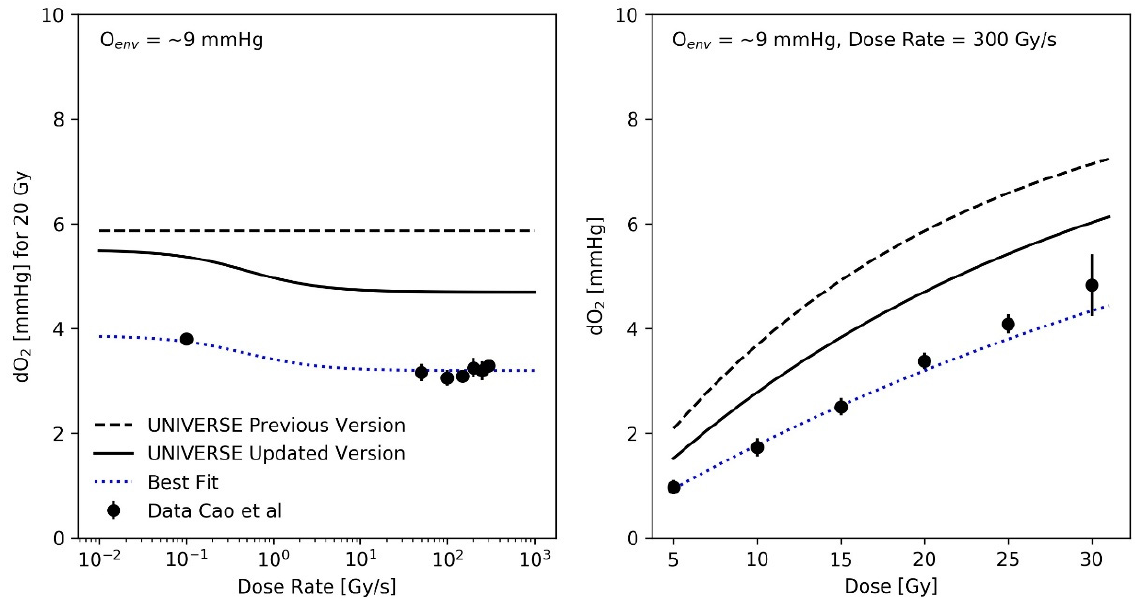
Figure 3. ( Left panel ): Measured oxygen depletion (filled circles) upon 20 Gy irradiation of aqueous solutions (containing bovine serum albumen [BSA] 5% w / w ) as function of dose rate obtained from Cao et al. [16] as compared against calculated values (dashed black line: previous implementation with constant g, dotted blue line: best fit parametrization of g using Equation (12) with Γ = 0.022, µ = 1.28, κ = 0.45, black solid line: modified parametrization of g using Equation (12) with Γ = 0.037, µ = 1.28, κ = 0.45). The modified parametrization converges to g = 0.037 Gy − 1 at high dose rates, as implied by prior findings. ( Right panel ): Measured oxygen depletion (filled circles) upon 300 Gy/s irradiation of aqueous solutions ([BSA] 5% w / w ) as a function of dose, obtained from Cao et al. [16] and predictions resulting from each